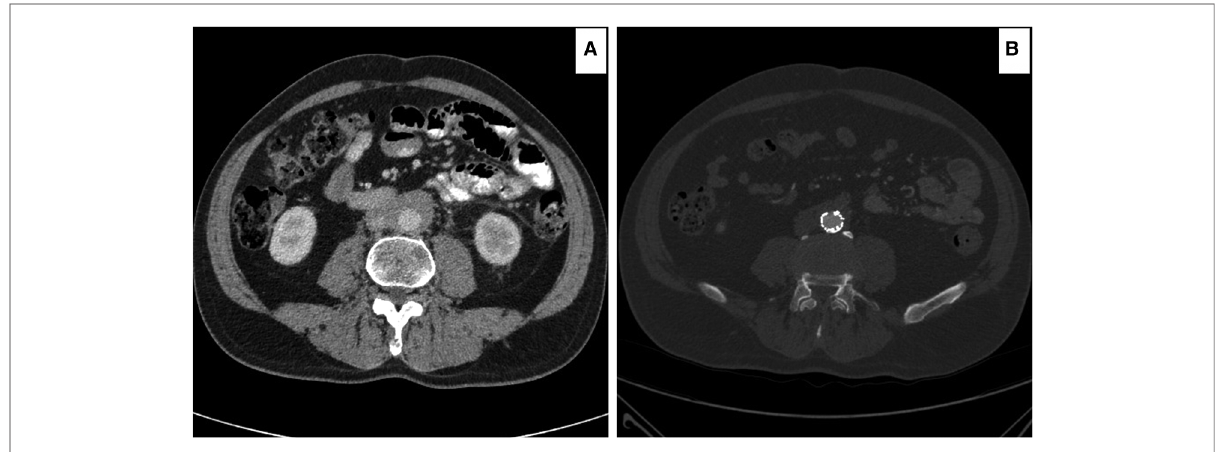
FIGURE 10 Computed tomography angiography (CTA) images showing improvement of the peri-aortic soft tissue enhancements following endovascular aneurysm repair (EVAR). ( A ) Post 16 months on optimal medical therapy, the peri-aortic soft tissue enhancement of 11 mm. ( B ) One year post- EVAR, all symptoms and signs disappeared with peri-aortic soft tissue enhancement of